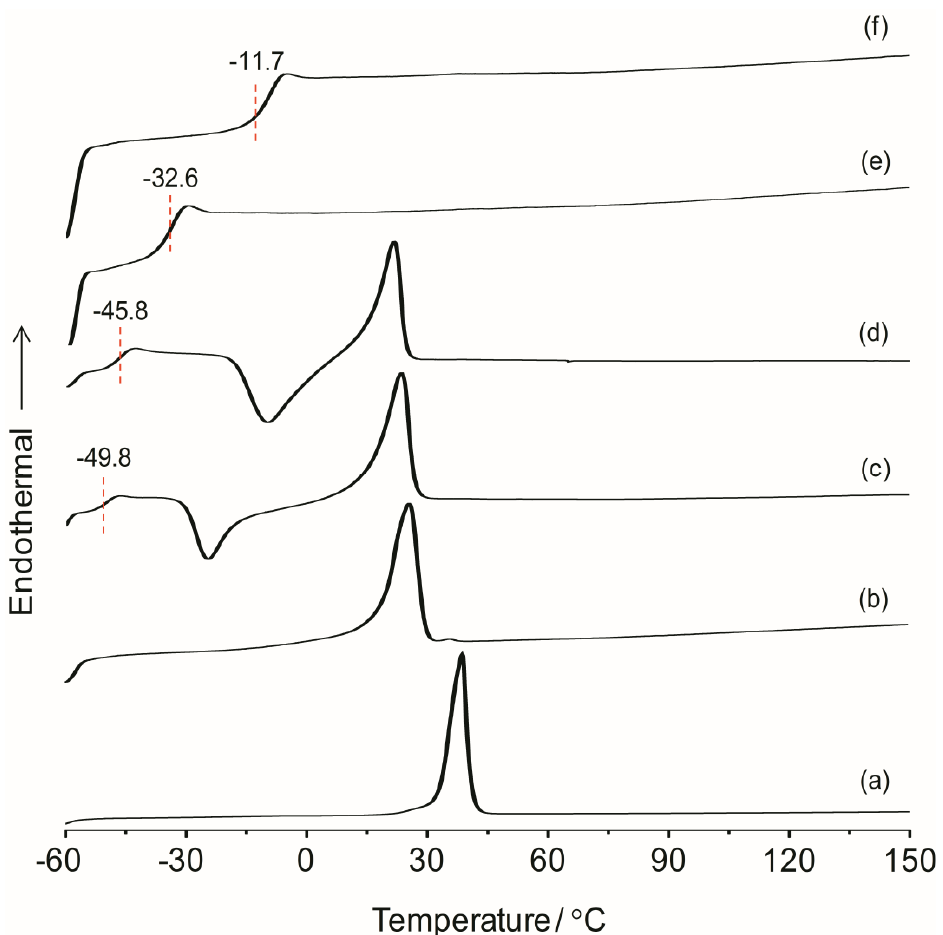
Figure 1. Differential scanning calorimetry (DSC) thermograms of ( a ) pure ED2000 and TIE(2000)-Z hybrid electrolytes with various [O]/[Li] ratios, where Z = ( b ) ∞ ; ( c ) 32; ( d ) 24; ( e ) 16 and ( f ) 8.